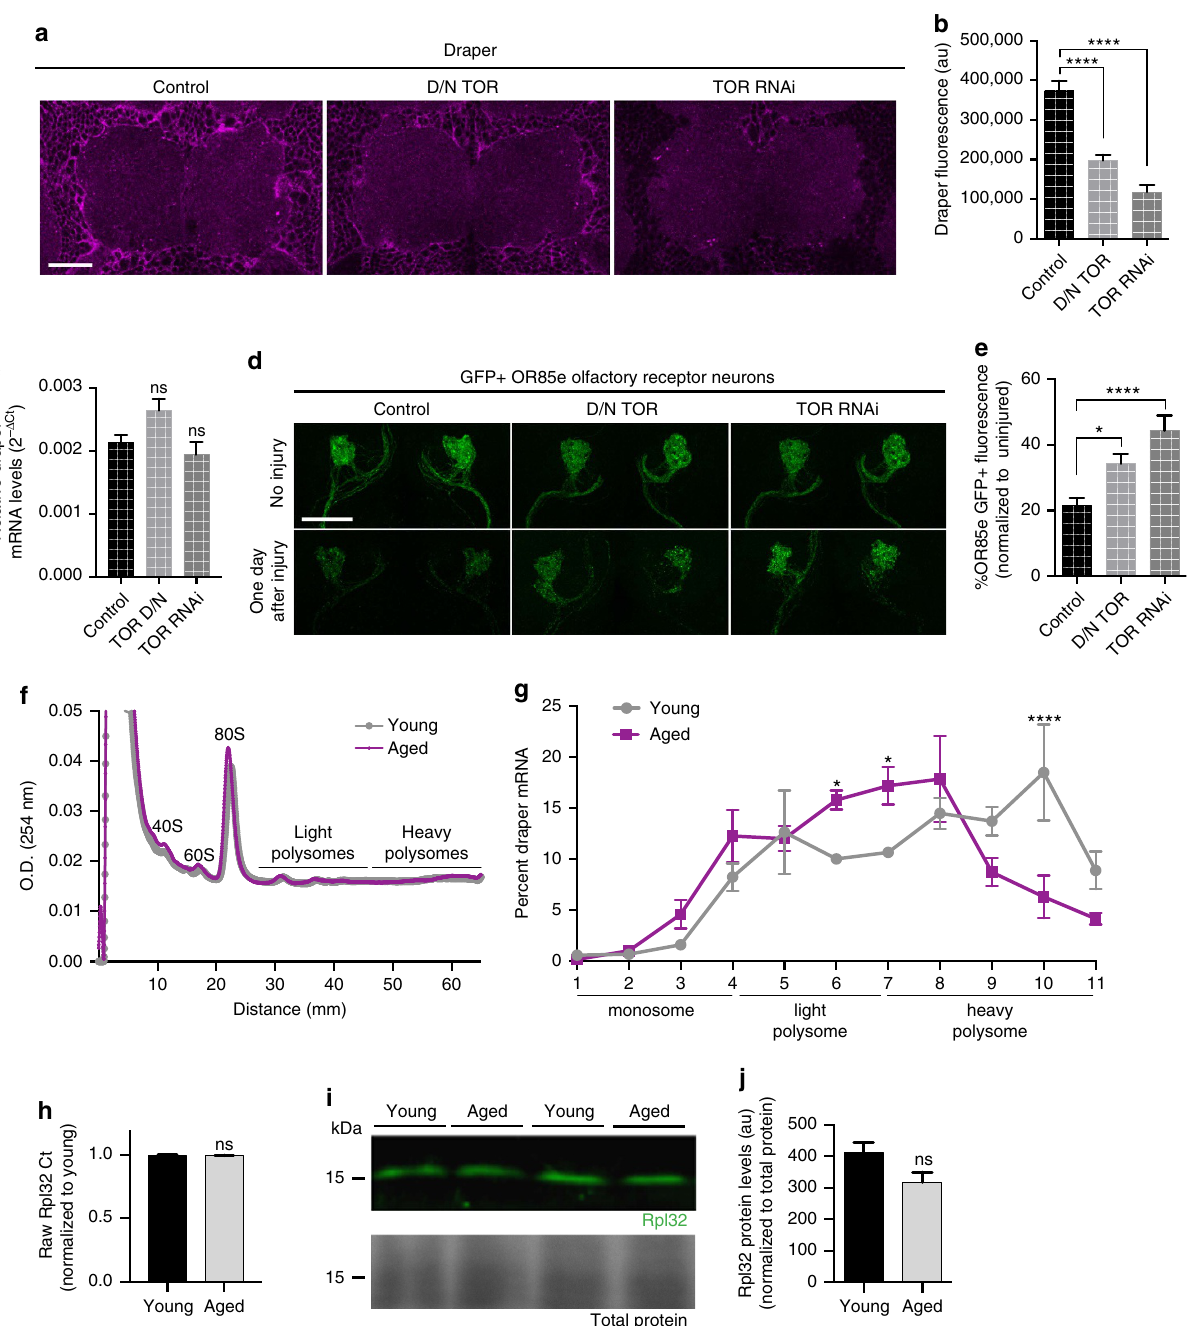
Figure 6 | Inhibition of TOR in adult glia inhibits Draper and glial clearance of axon debris in young animals. ( a ) Single confocal slices of antennal lobe regions. Brains immunostained with Draper. ( b ) Quantification of cortical Draper immunostainings shown in a ; mean ± s.e.m. plotted; **** P o 0.0001, one- way analysis of variance (ANOVA) with Sidak post-hoc test; N Z 16. ( c ) Quantitative PCR (qPCR) analysis of draper-I transcript levels in adult heads; mean ± s.e.m. plotted, NS, not significant, one-way ANOVA with Sidak post-hoc test; N ¼ 3 biological replicates. ( d ) Representative Z -stack projections of OR85e GFP þ axons. ( e ) Quantification of GFP þ axonal debris shown in d ; mean ± s.e.m. plotted; * P o 0.05 and **** P o 0.0001, one-way ANOVA with Sidak post-hoc test. N ¼ 22. ( f ) Polysome profiles for young and aged whole head lysates resolved on a 10–60% sucrose gradient. Absorbance continuously monitored at 254nm during fractionation shown. ( g ) draper-I mRNA in each fraction was quantified by qPCR and normalized to the housekeeping gene Rpl32 and luciferase (control for RNA recovery). mean ± s.e.m. plotted; * P o 0.05 and **** P o 0.0001, two-way ANOVA with uncorrected Fisher’s LSD post- hoc test. N ¼ 3 groups of 30 w 118 fly heads/age. ( h ) Normalized Rpl32 Ct values pooled from four experiments on young and aged w 118 brain lysates; mean ± s.e.m. plotted, NS, not significant, unpaired t -test. N ¼ 17 biological replicates/age. ( i ) Representative western blotting for Rpl32 (green) and MemCode total protein stain (bottom panel) performed on head lysates from young and aged flies. ( j ) Quantification of Rpl32 western blottings; unpaired t -test. N ¼ 4 biological replicates/age. Genotypes: a – e , Control ¼ w 1118 ;OR85e-mCD8::GFP, tubulin-Gal80ts/ þ ; repo-Gal4/ þ . D/N TOR ¼ w 1118 ;OR85e- mCD8::GFP, tubulin-Gal80ts/ þ ; repo-Gal4/UAS-D/N TOR . TOR RNAi ¼ w 1118 ;OR85e-mCD8::GFP, tubulin-Gal80ts/ þ ; repo-Gal4/UAS-TOR RNAi . f – j , w 1118 . Scale bars ¼